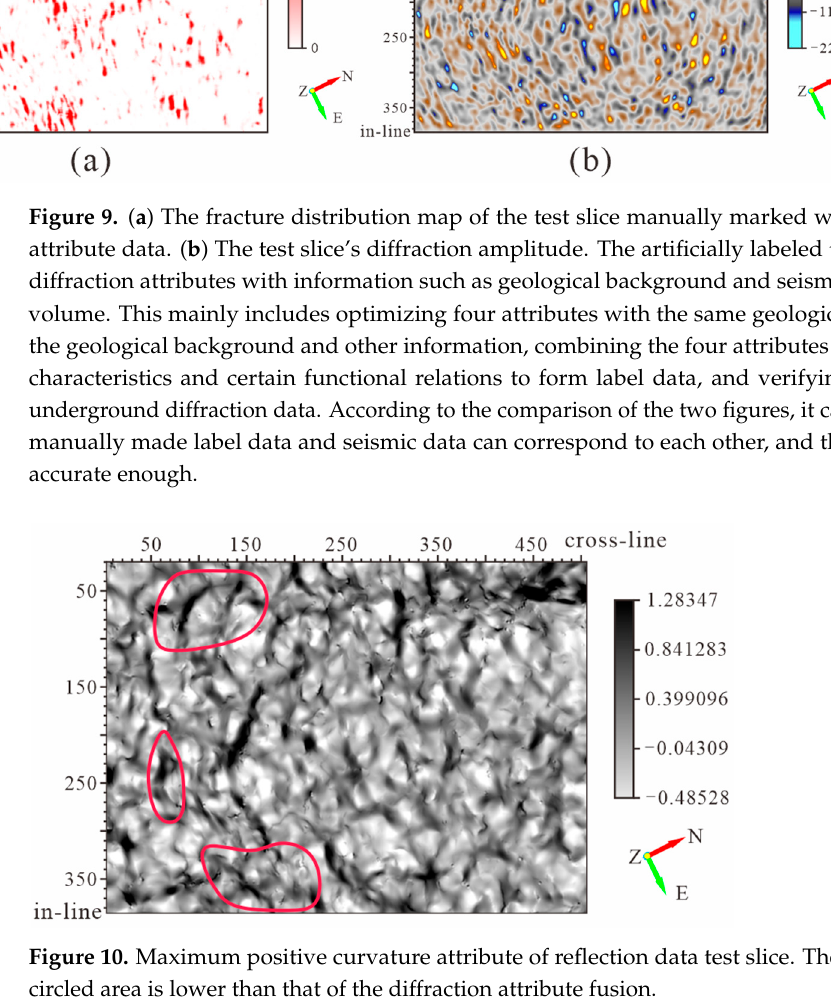
Figure 10. Maximum positive curvature attribute of reflection data test slice. The resolution of the circled area is lower than that of the diffraction attribute circled area is lower than that of the diffraction attribute fusion.